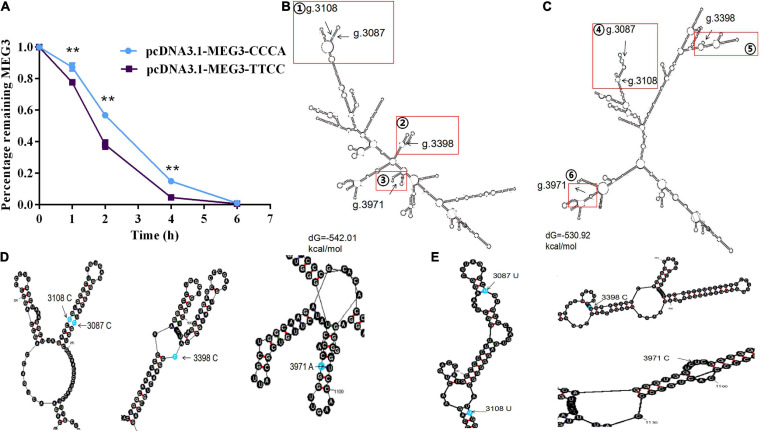
The effect of haplotypes on the stability of MEG3 and the prediction of their secondary structure. (A) Percentage of remaining MEG3 level in SCs transfected with pcDNA3.1-MEG3-CCCA or pcDNA3.1-MEG3-TTCC and incubated with 20 μg/mL actinomycin D for appointed time. The significance test: **P < 0.01. (B,C) showed secondary structure and minimum free energy of the MEG3-CCCA and MEG3-TTCC, respectively. Four SNP sites were marked with red squares. (D,E) showed the enlarged views of the area indicated by the red rectangle from (B,C), respectively.